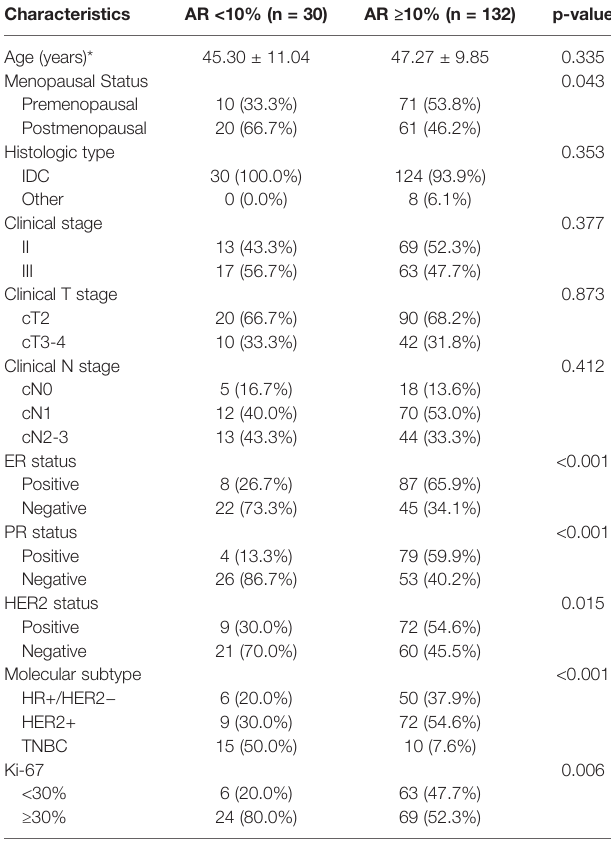
TABLE 2 | Clinical and histopathologic characteristics of patients grouped by AR expression.